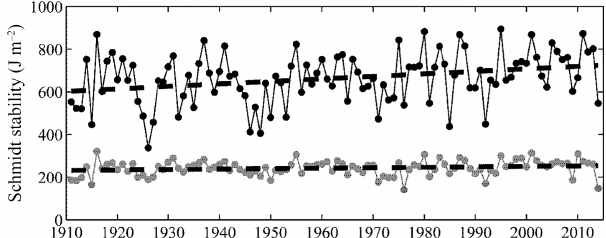
Figure 6. Yearly average summertime (15 July–15 August) Schmidt stability values for Lake Mendota (black) and Fish Lake (gray). Dashed lines represent the long-term trend for each lake.